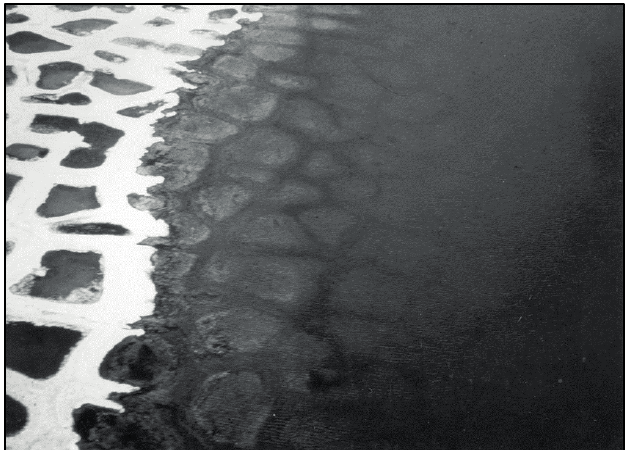
Fig. 2 Relief inversion due to ice wedge